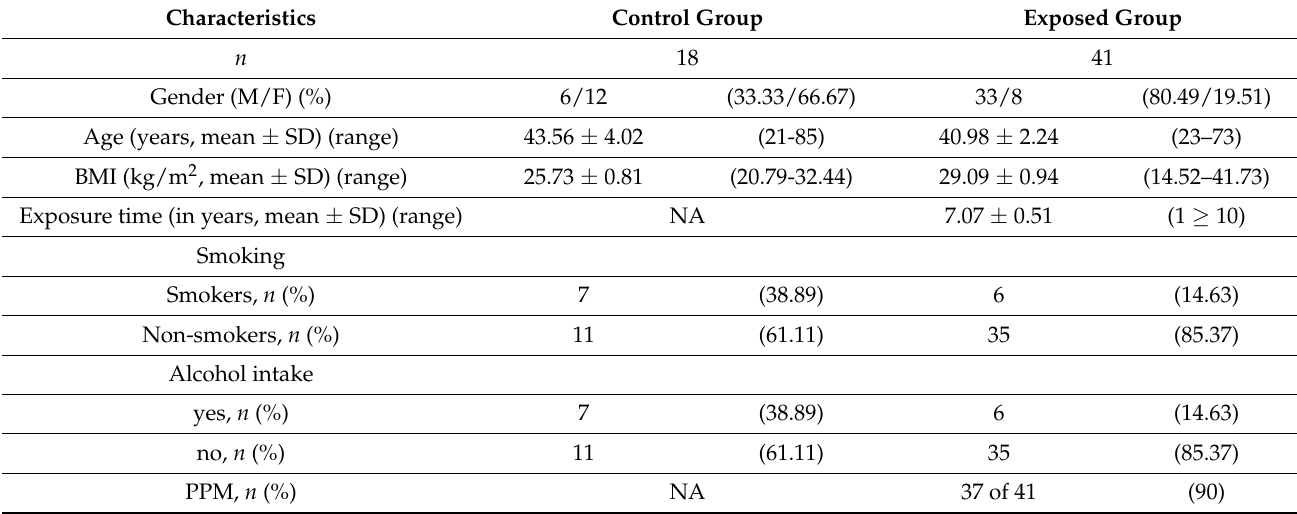
Table 1. Characteristics of the control and the exposed